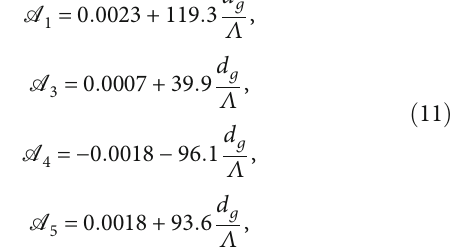
Figure 8: d vs. Λ for observable C g 3ab − 1